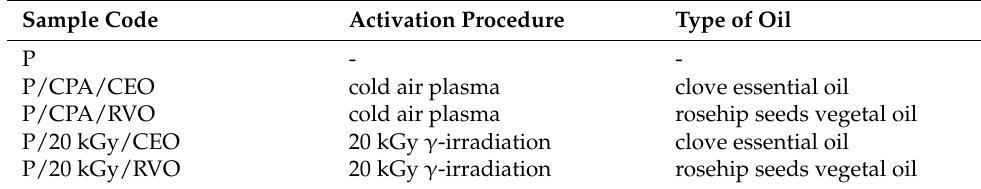
Table 1. Codes and description of studied samples based on kraft paper